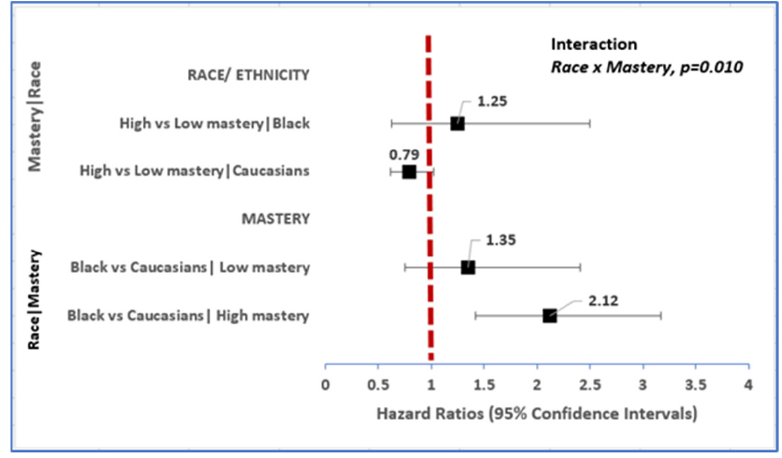
Figure 3. Race-related differences in risk of incident dementia vary within strata of mastery. Conversely, among older adults categorized as having low mastery level, the relative hazard of dementia diagnosis was 87% elevated for adults reporting ≥ 1 vs. zero cumulative stress events (HR 1.87, 95% CI: 1.16–3.00). This relative hazard among adults in the low mastery category corresponds to an average of 2.5 years earlier dementia onset for individuals reporting ≥ 1 vs. zero cumulative stress (- i.e., 79.5 vs. 82.0 years, respectively). Among older adults classified as having high mastery, the experience of ≥ 1 vs. zero cumulative stress events was not associated with incident dementia diagnosis (HR 1.04, 95% CI: 0.66–1.65, Figure 4). This relative hazard on average corresponded to 1.9 years earlier dementia diagnosis for high mastery adults reporting ≥ 1 vs. zero cumulative stress events (79.7 vs. 81.6 years, respectively).